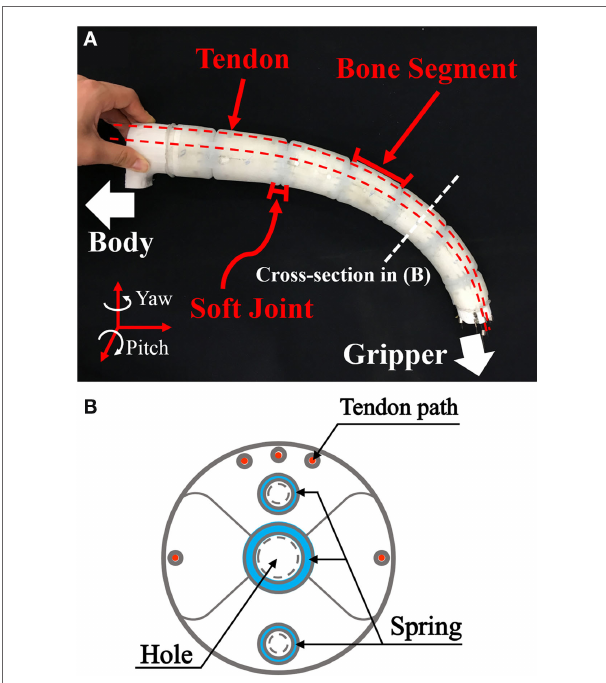
FigUre 5 | Design of the PVsM . (a) The manipulator is composed of soft joints and rigid “bone” segments and has five embedded tendon routes. (B) Cross-sectional view of the rigid “bone” segments of the manipulator. Holes near the circumference admit tendon wires, and two embedded springs constrain the pitch motion of the